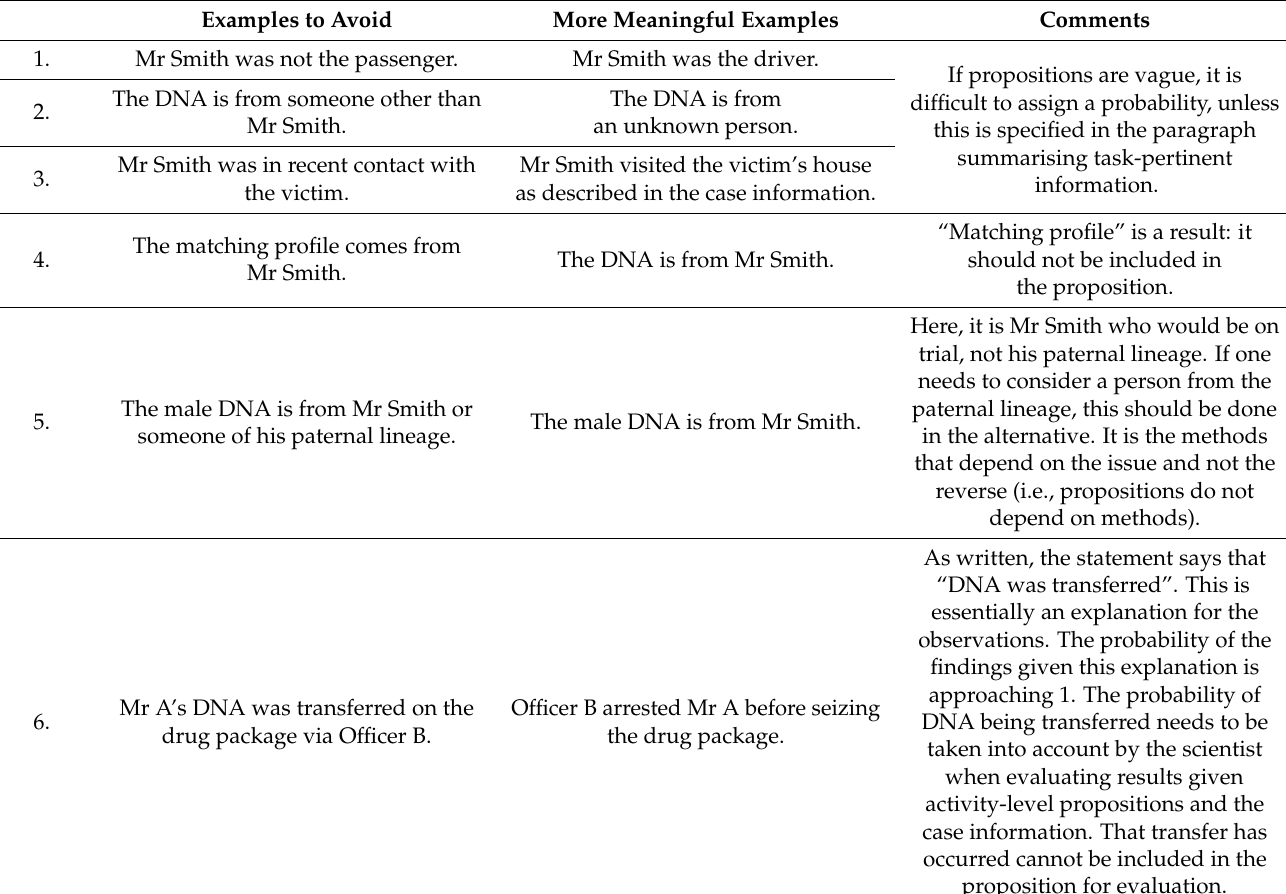
Table 6. Examples of propositions that should be avoided and how to formulate them in a more meaningful